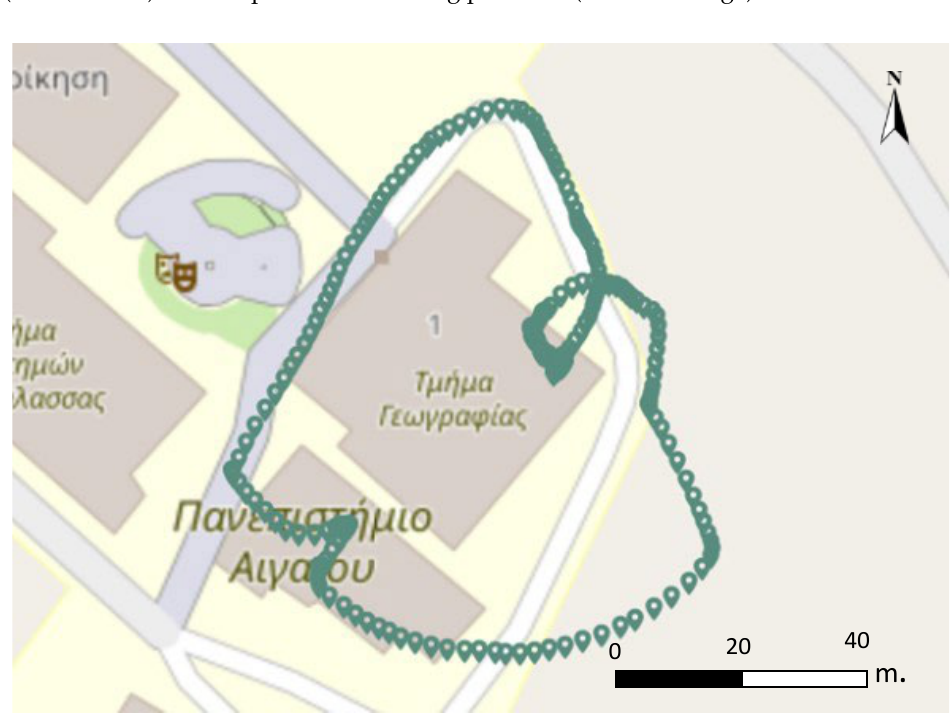
Figure 12. Trajectory visualization (green points).